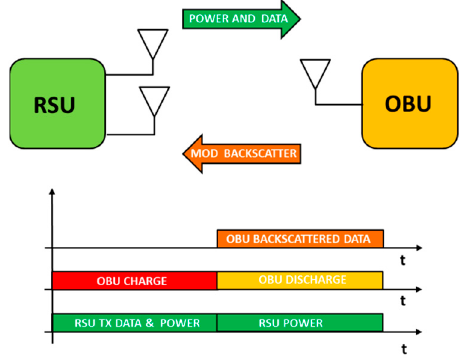
Figure 1. Principle of operation of a battery-less OBU.